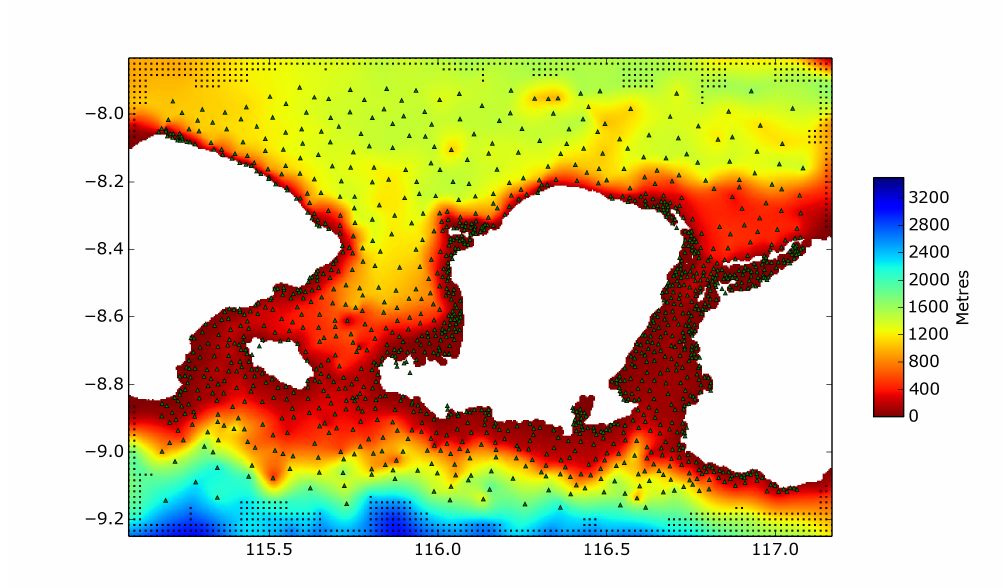
Figure 5. The model bathymetry over the model domain for the Lombok/Alas Straits model. The triangles are the locations of the Admiralty Chart data and the squares are the ETOPO1 data points used at the